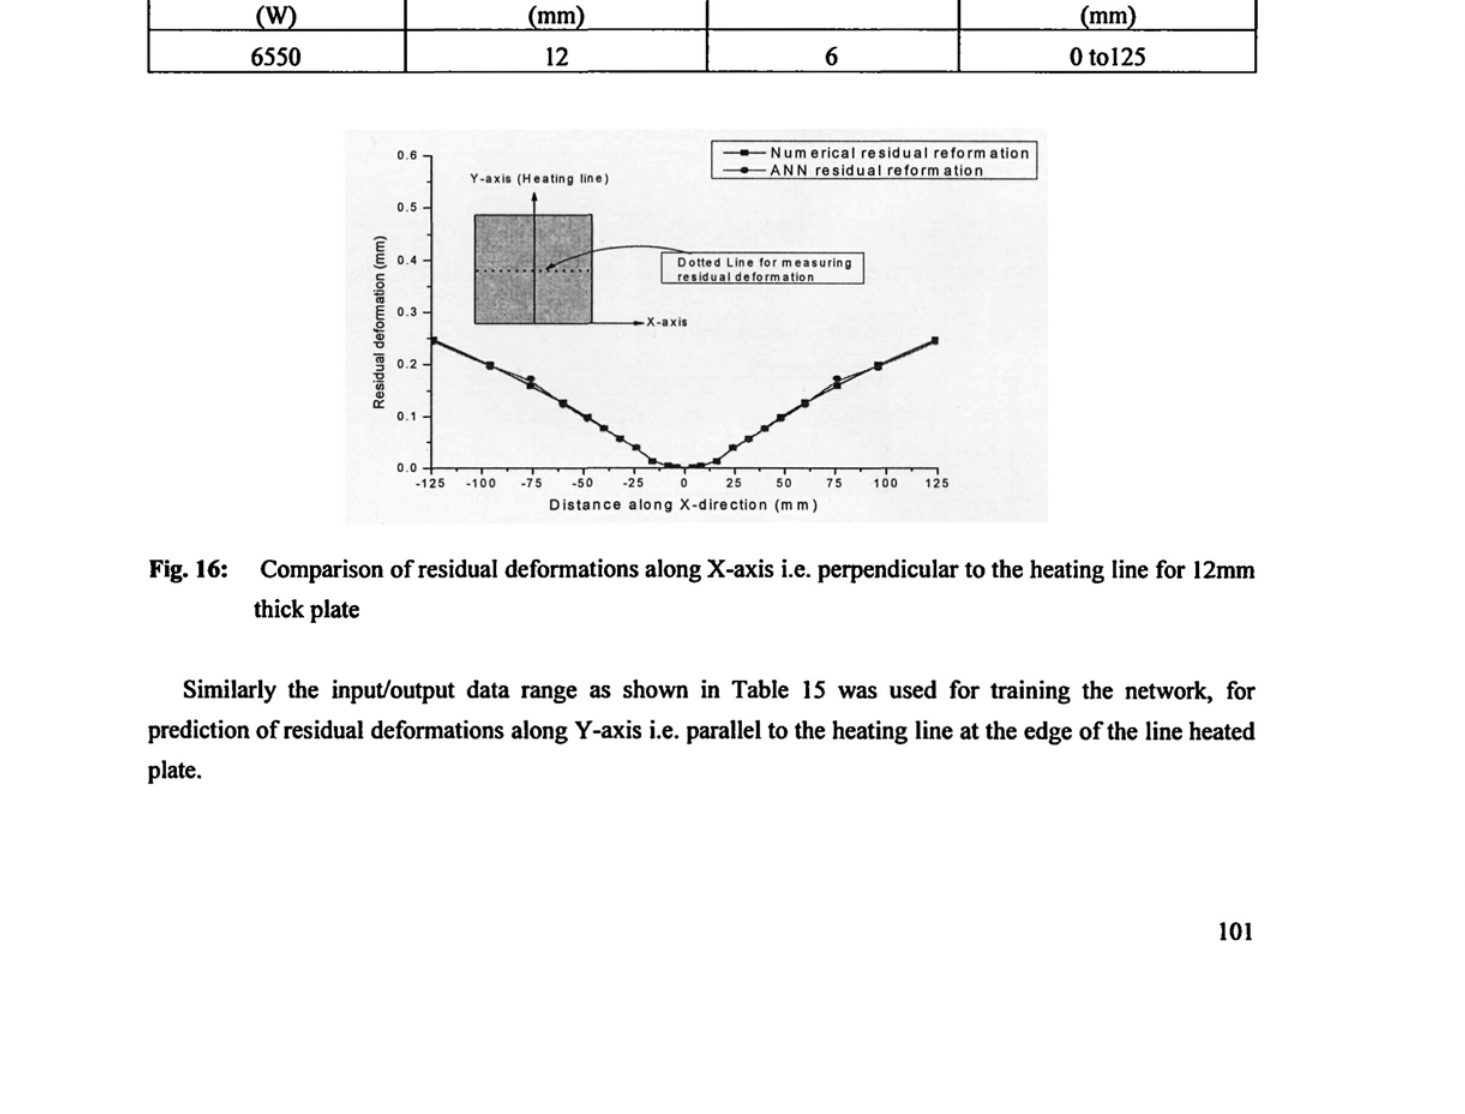
Fig. 16: Comparison of residual deformations along X-axis i.e. perpendicular to the heating line for 12mm thick plate Similarly the input/output data range as shown in Table IS was used for training the network, for prediction of residual deformations along Y-axis i.e. parallel to the heating line at the edge of the line heated